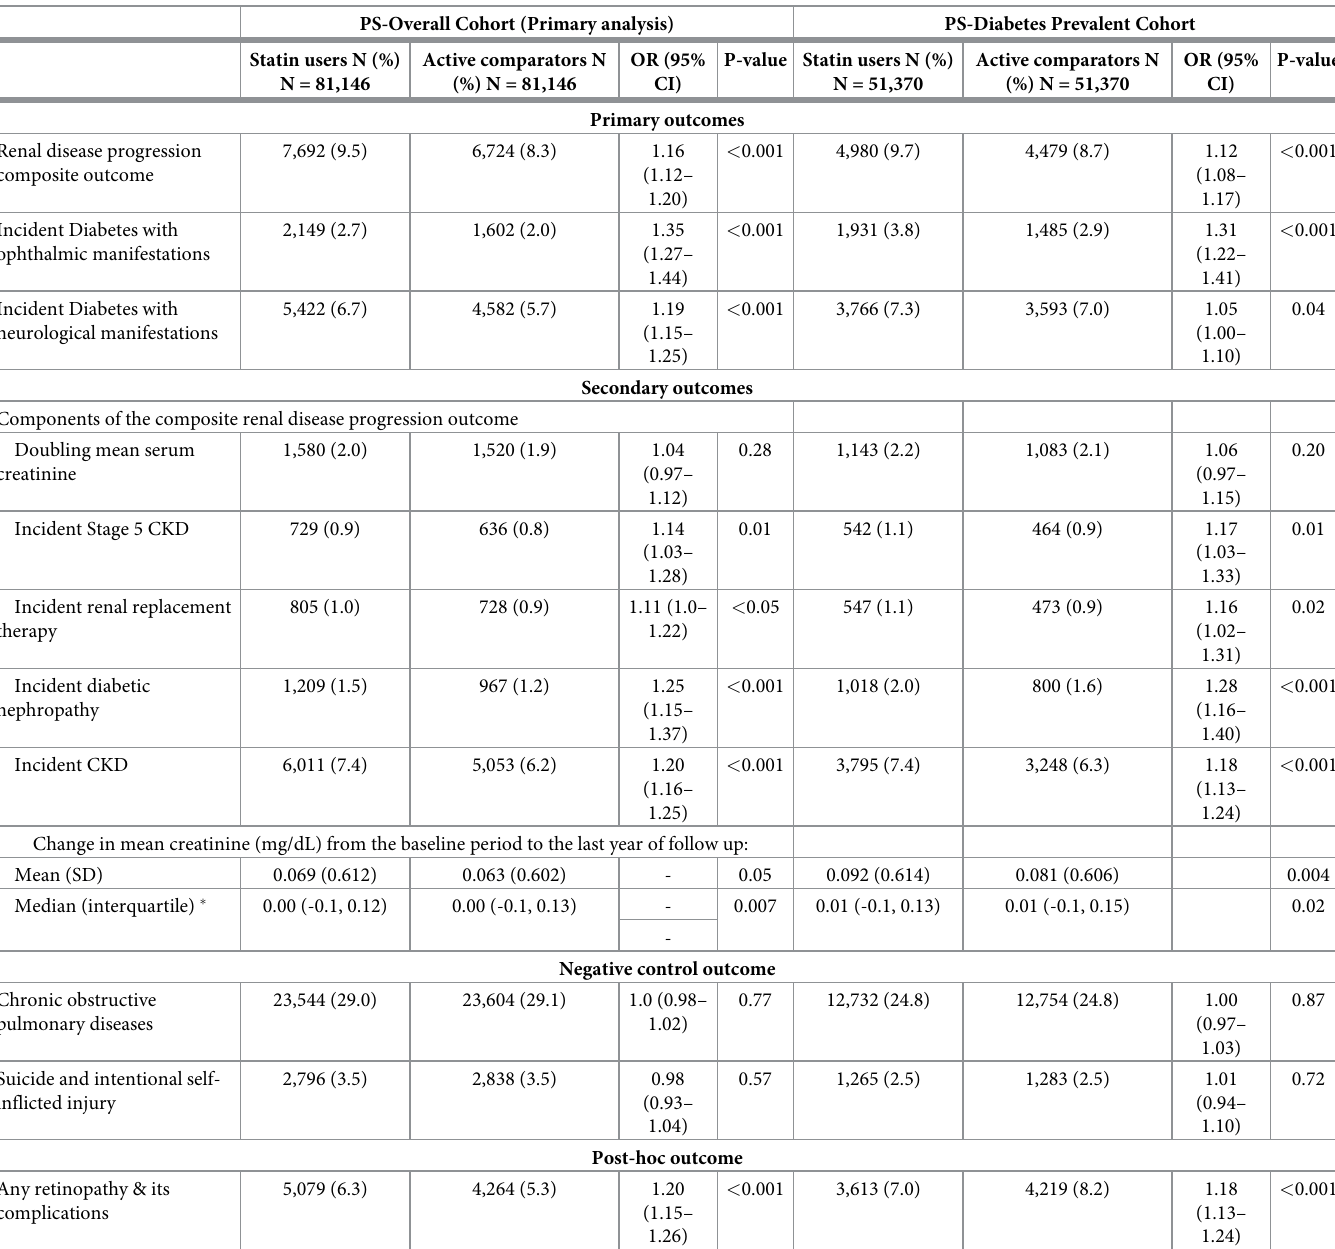
Table 2. Risk of outcomes during follow up period in propensity score matched cohort of statin users in comparison to active